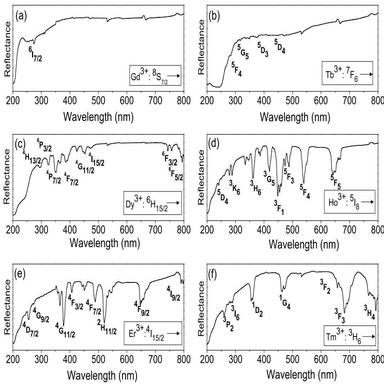
Diffuse reflectance spectra for the selected Ln2Ge2O7 materials in the range 200–800 nm, with the identification of the main intraconfigurational f-f transitions for tetragonal pyrogermanates: (a) Gd2Ge2O7; (b) Tb2Ge2O7; (c) Dy2Ge2O7; (d) Ho2Ge2O7; (e) Er2Ge2O7; and (f) Tm2Ge2O7 samples.